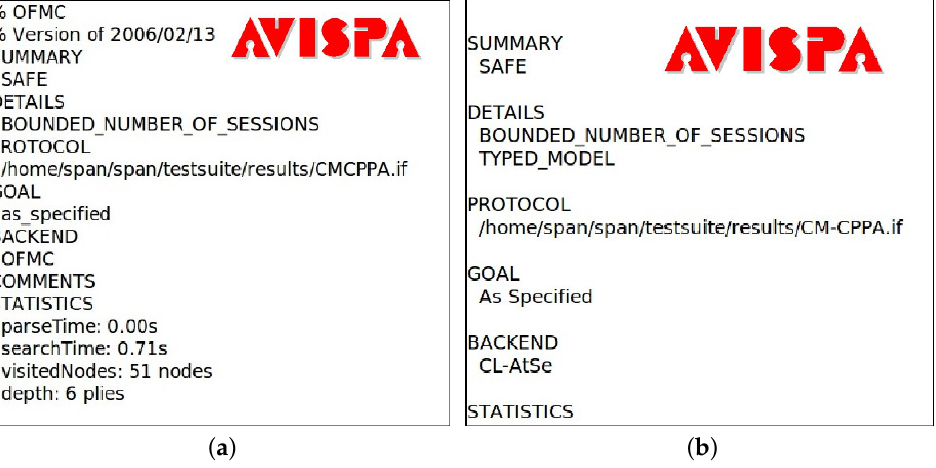
Figure 4. The simulation results under OFMC and CL-AtSe Back Ends. ( a ) OFMC back end; ( b ) CL-AtSe back